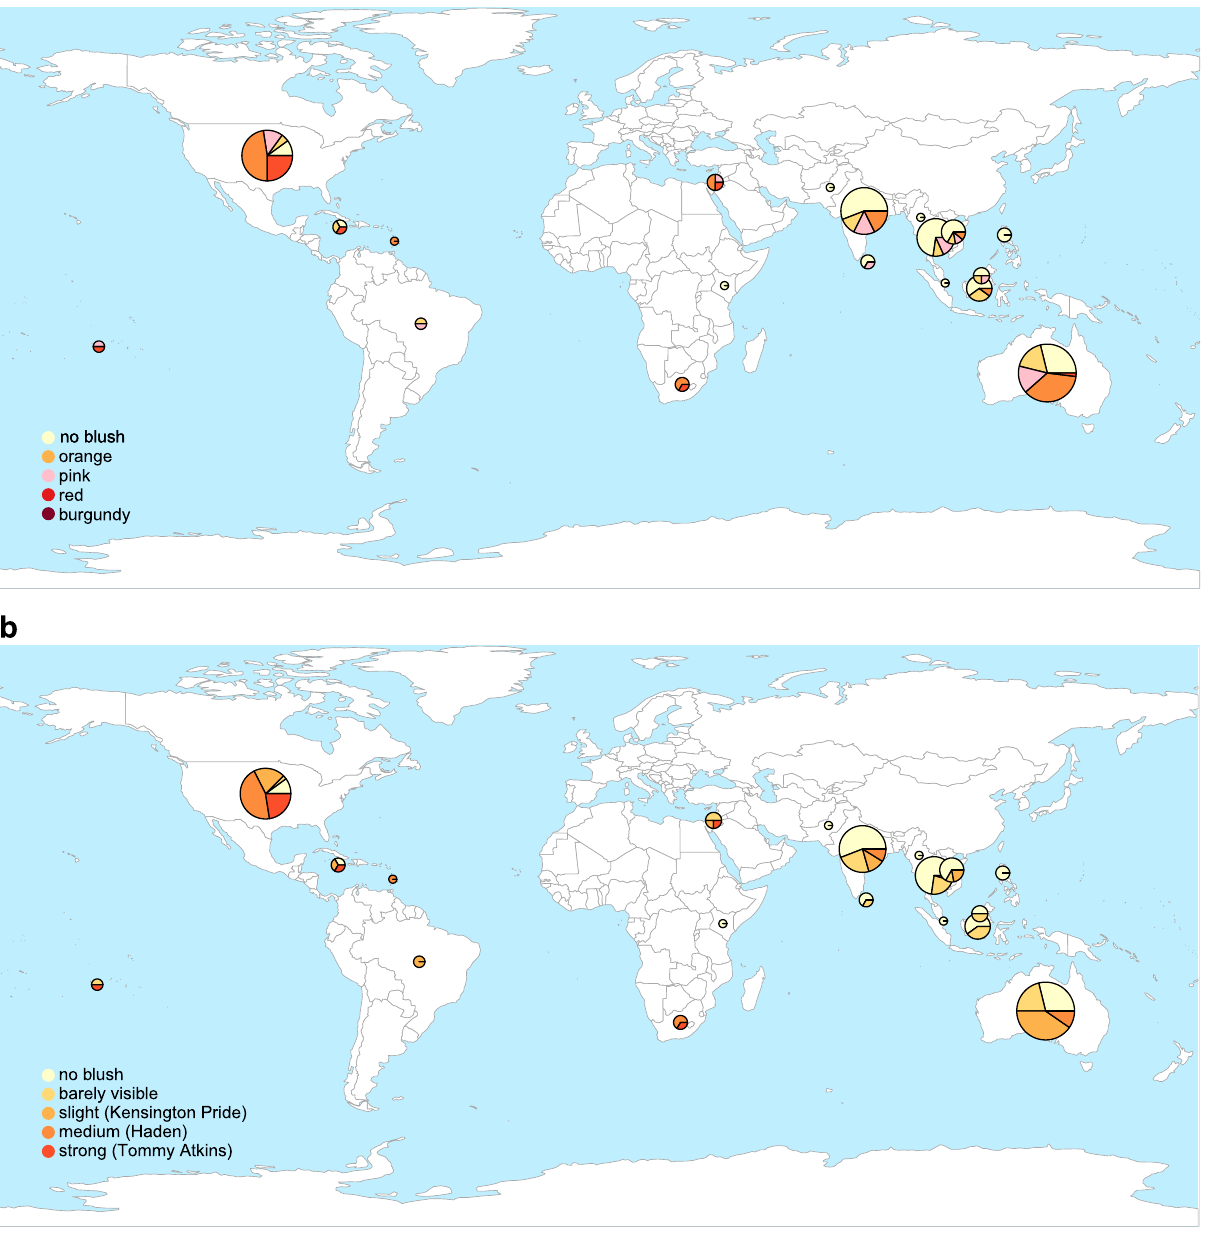
Figure 4. Fruit blush colour and intensity across geography of the 208 M. indica accessions. ( a ) Fruit blush colour is split into five categories. ( b ) Fruit blush intensity increases from no blush to strong blush on an ordinal scale, where the accessions in brackets best reflect the colour intensity. The size of each pie chart reflects the number of accessions imported from each country. The world map was created in “rworldmap” v1.3-6 R-package (https:// cran.r- proje ct. org/ web/ packa ges/ rworl